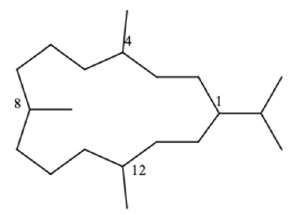
Figure 1. Cembrane skeleton.